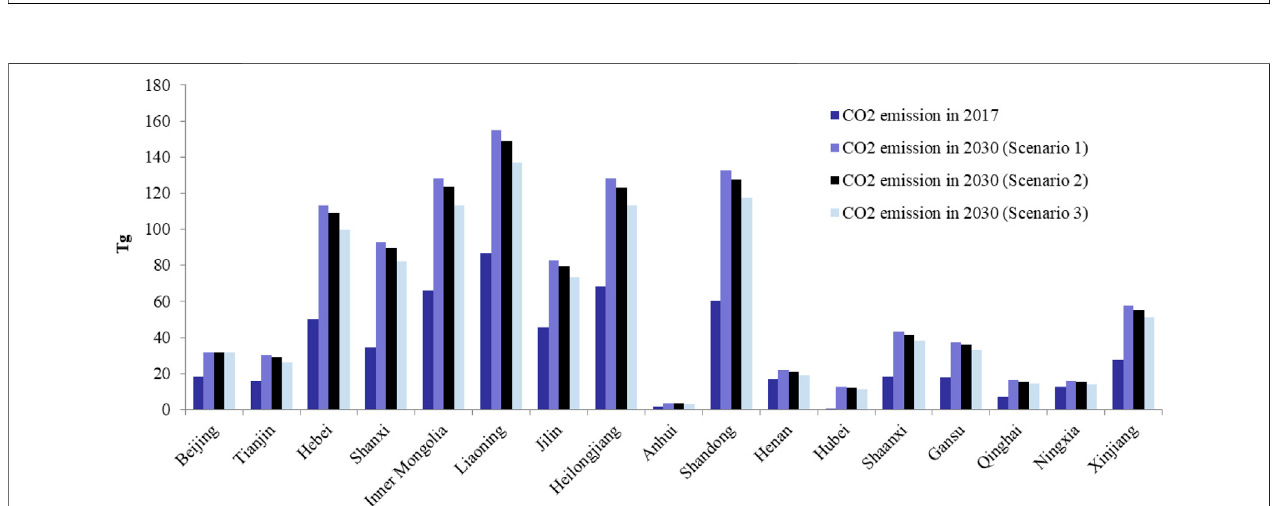
FIGURE 6 | Gas consumption of central heating in 2030.